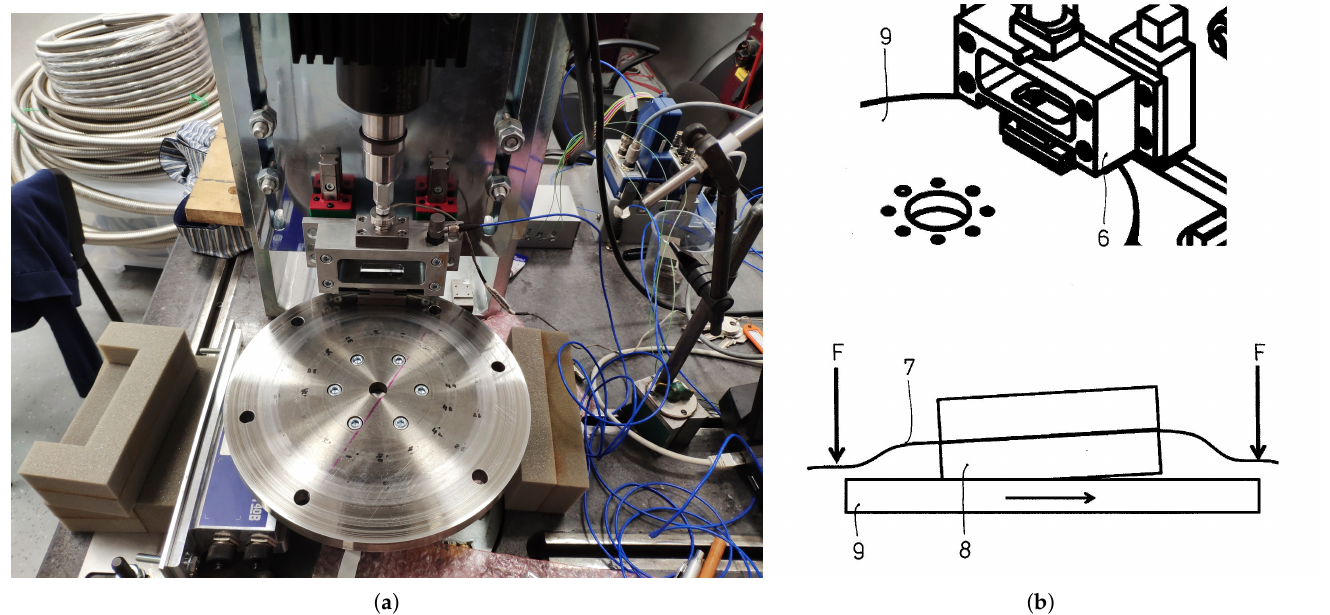
Figure 3. ( a ) Pad-on-disc experimental test bench, ( b ) working principle of pad-on-disc; 6—pad support, 7—thin plate, 8—friction material,